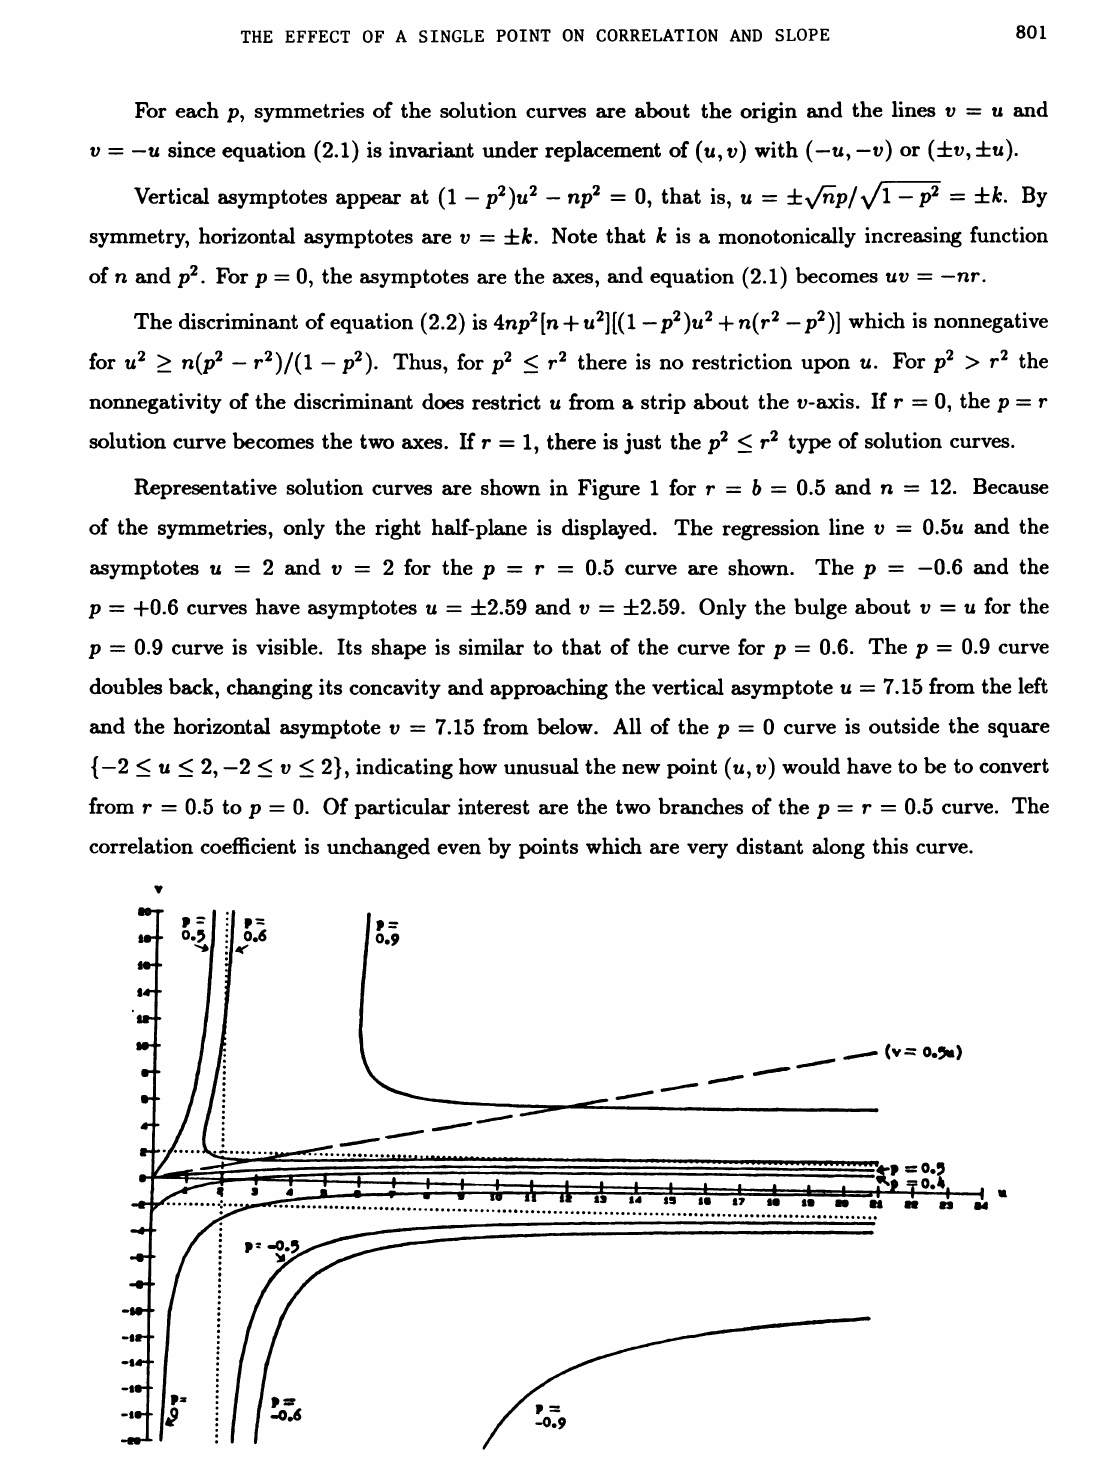
Figure 1: Curves along which (u, v) may be placed to change the value of the correlation coefficient to selected values p for